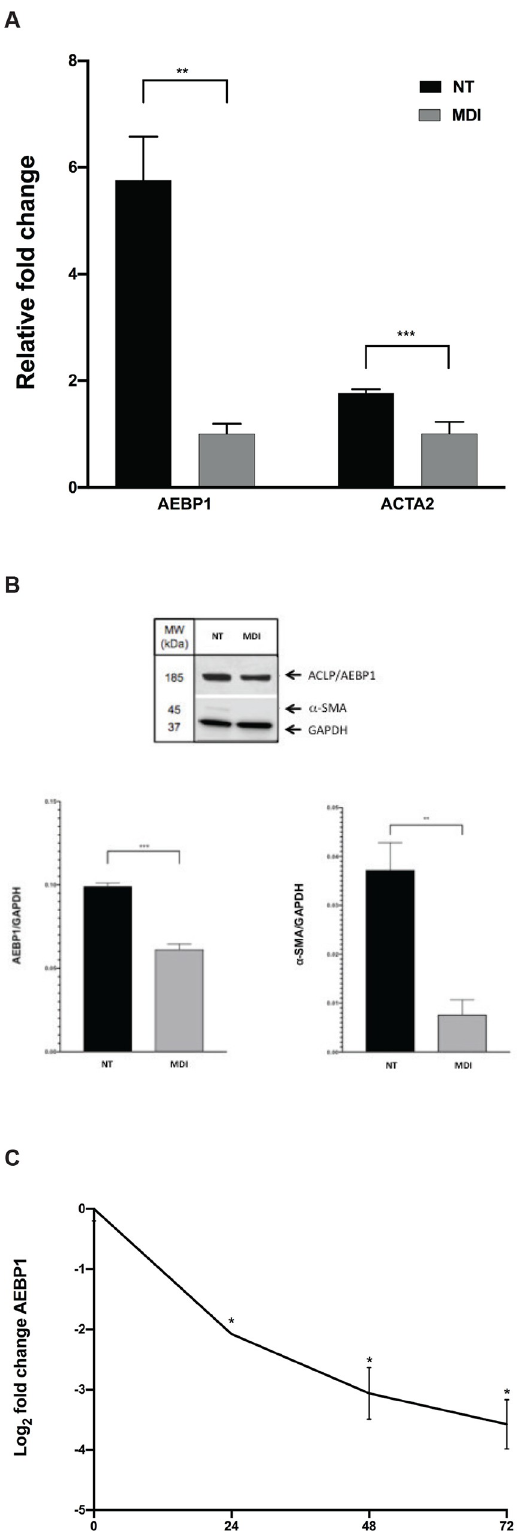
Fig 2. AEBP1 expression in untreated and MDI-treated LX-2 cells. A) AEBP1 and ACTA2 mRNA levels were measured by qPCR in no treatment controls (NT; i.e., activated) and MDI-treated (i.e., quiescent) LX-2 cells. AEBP1